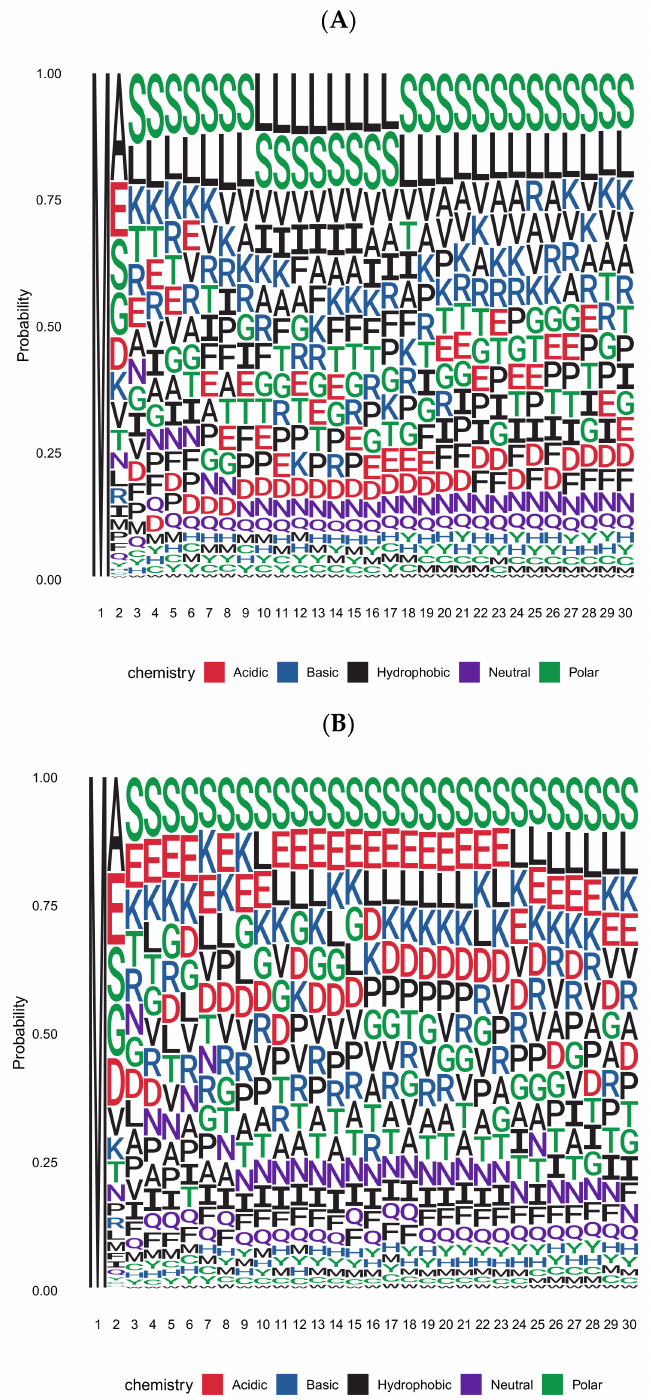
Figure 1. Position-specific amino acid probability in the first thirty residues of Arabidopsis proteins represented as a sequence logo (in single letter code). ( A ) Sequence logo based on the complete set of nuclear-encoded proteins with one representative per gene. ( B ) Sequence logo based on the subset of proteins with predicted localization exclusively in cytoplasmic or nuclear compartments. Predictions were obtained from